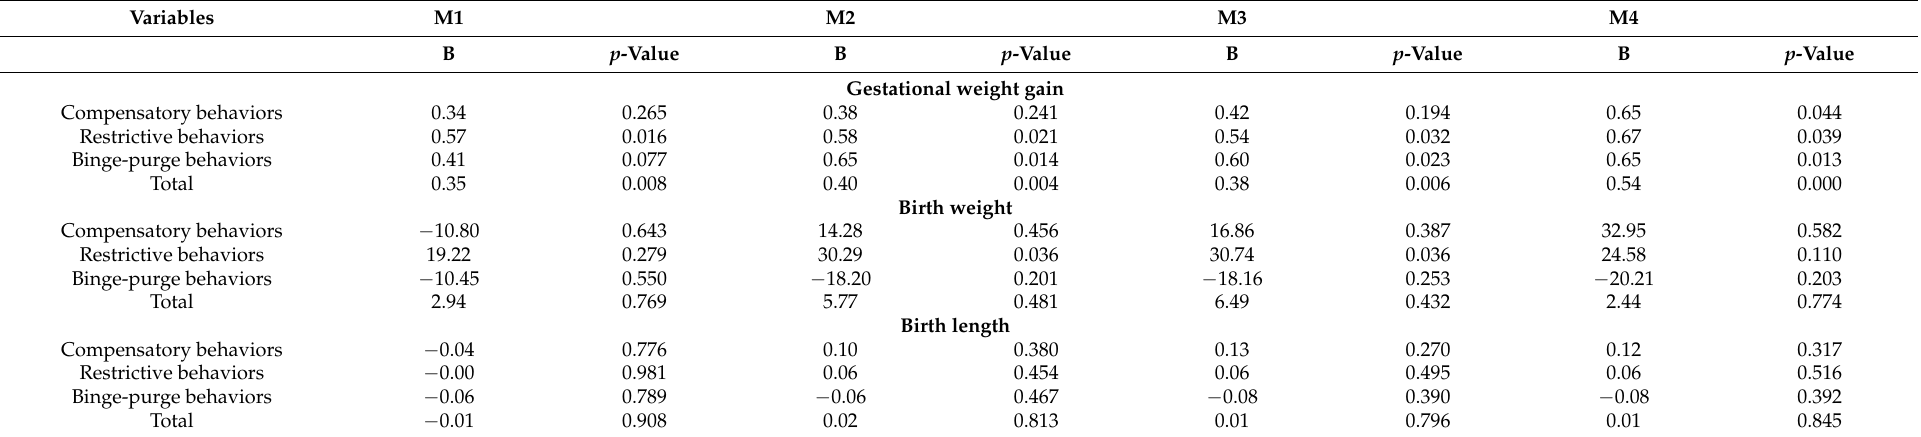
Table 4. Linear regression models of the association of gestational weight gain, birth weight and length, with disordered eating